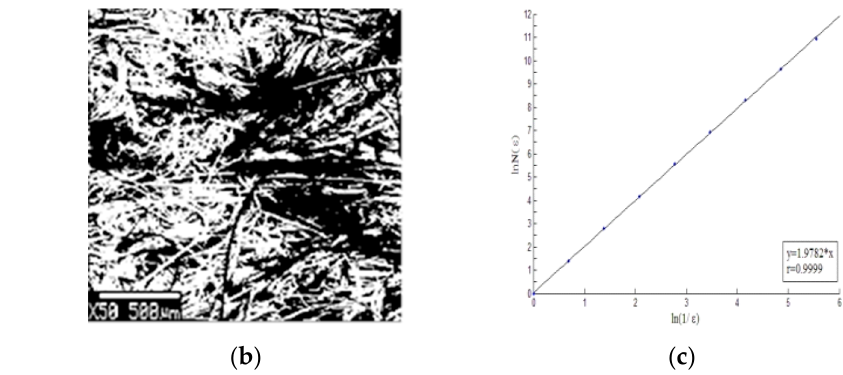
Figure 6. Fractal dimension results of nonwoven fabrics: ( a ) SEM image, ( b ) image after pretreatment, and ( c ) fractal dimension calculation.